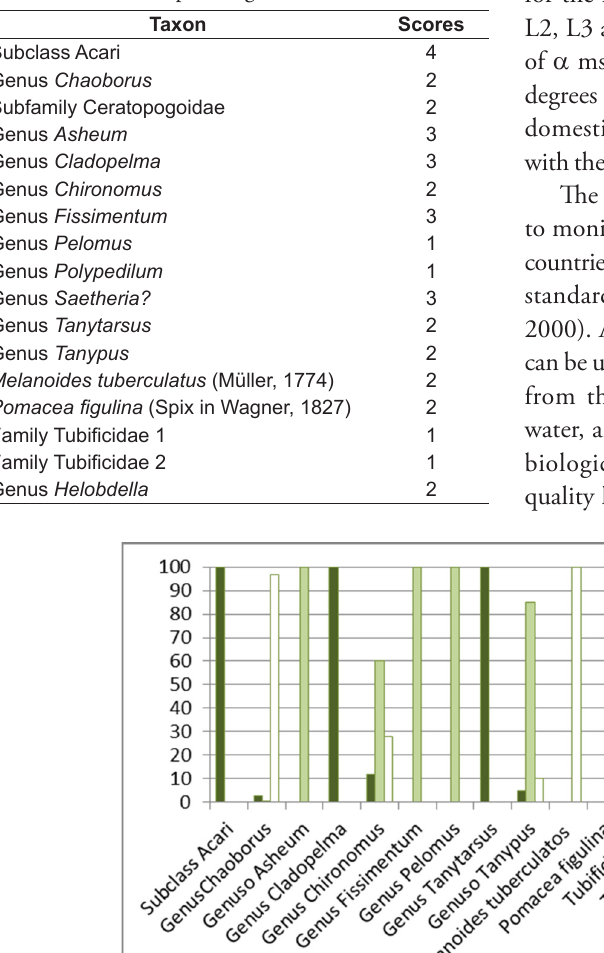
Table 5. Scores assigned to each taxon of benthic mac- roinvertebrates in Itupararanga Reservoir.